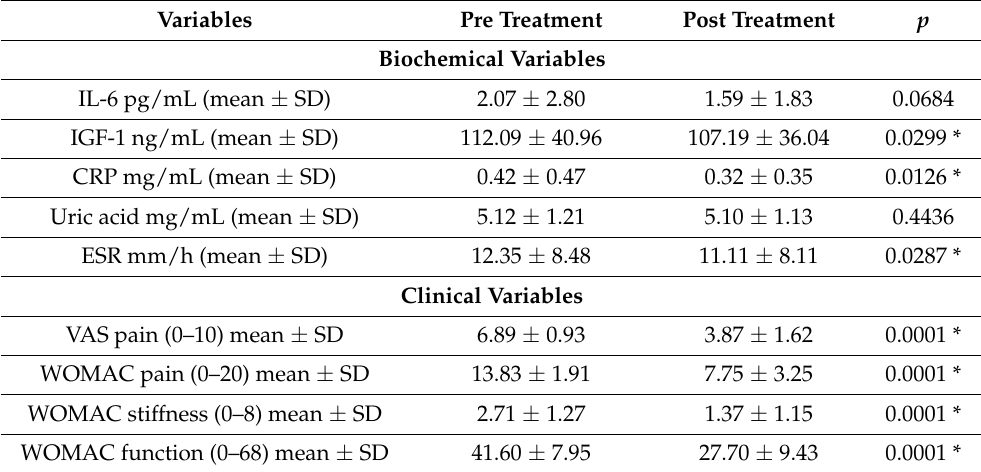
Table 2. Clinical and biochemical variables before-and after Ozone treatment in knee osteoarthritis patients (n =